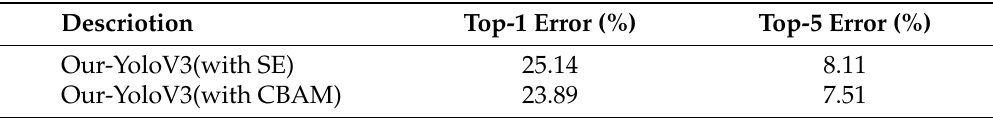
Table 5. The YOLOv3 improved in this paper deployed the SE attention mechanism and CBAM respectively, and compares the error of Top-1 and